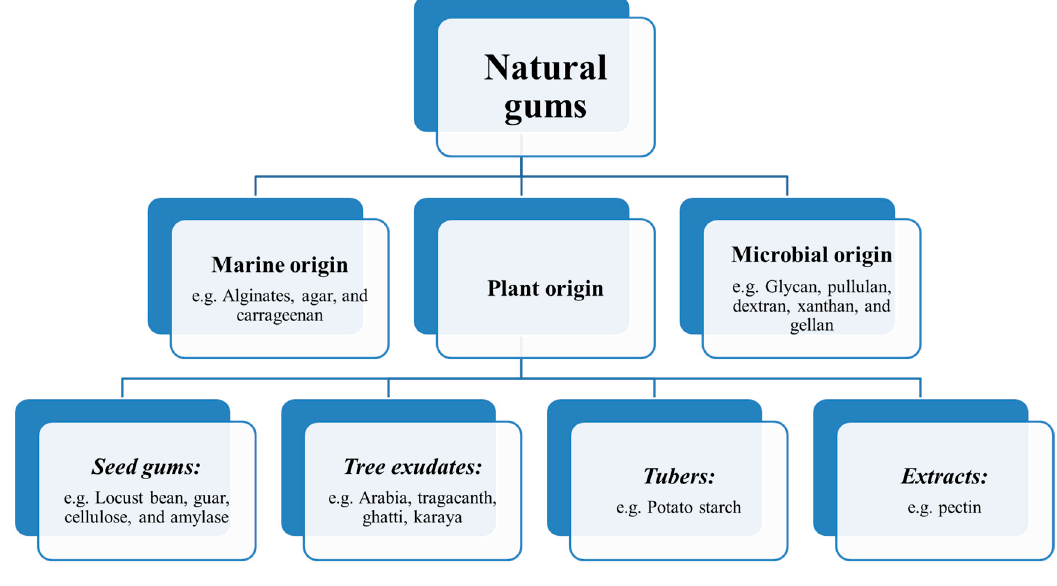
Figure 1. Origin of the natural gums.